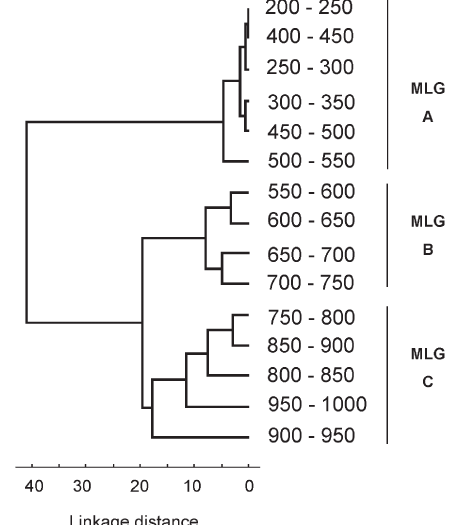
Fig. 2 . – dendrogram resulting from the hierarchical cluster analy- sis of the mean weight of each prey item by predator length class of 50 mm using Ward’s method and Manhattan distances. Three major length groups (MLgs) were defined: a) 200-550 mm, B) 550-750 mm, and C) 750-1000 mm.